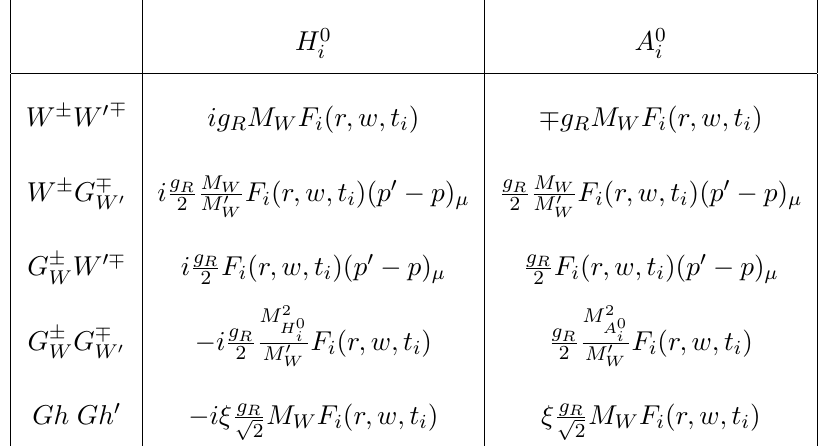
Table 11 . Couplings of neutral (pseudo)scalar bosons to gauge bosons, Goldstone bosons and ghosts.